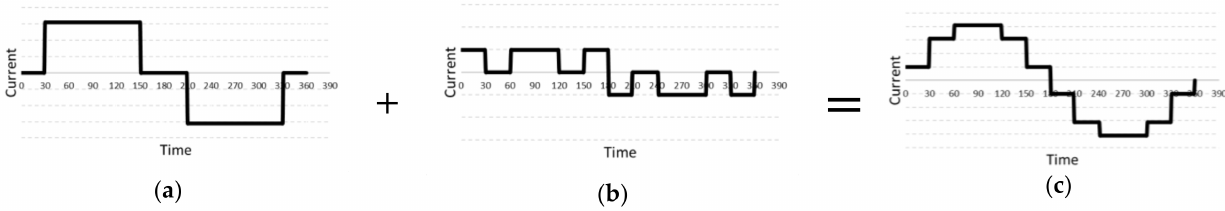
Figure 18. Current waveforms in phase a of the HTR. ( a ) Input current at rectifier 1. ( b ) Input current at rectifier 2. ( c ) Input current (12 multilevels) at